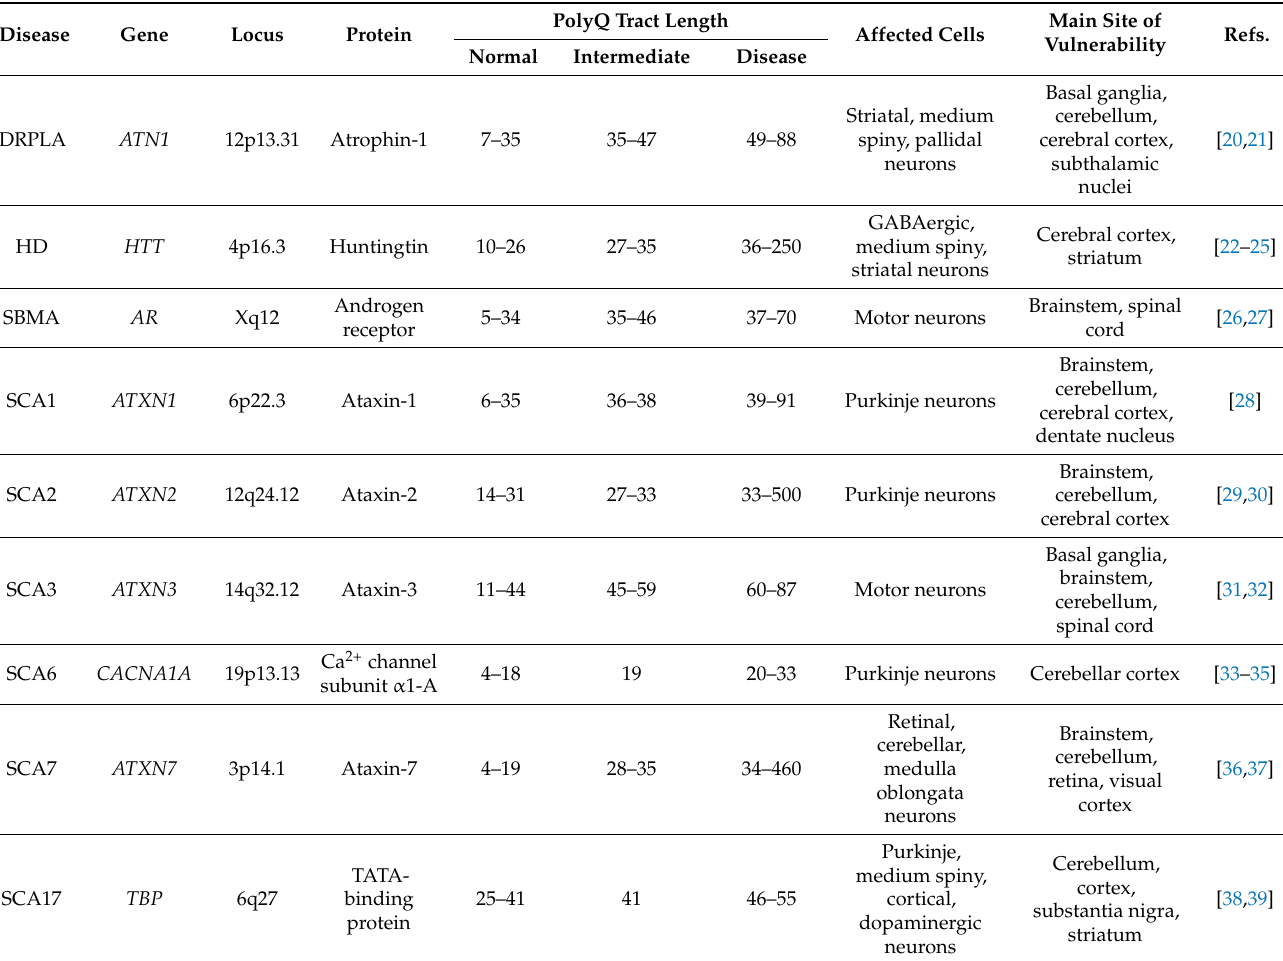
Table 1. Characteristics of polyQ